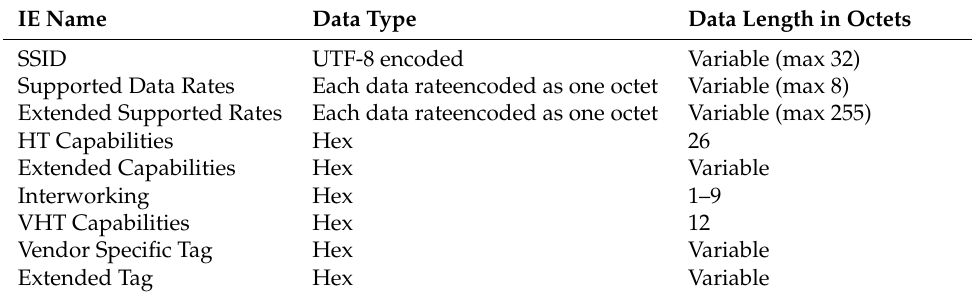
Table 1. Selected IEs, their data type and data